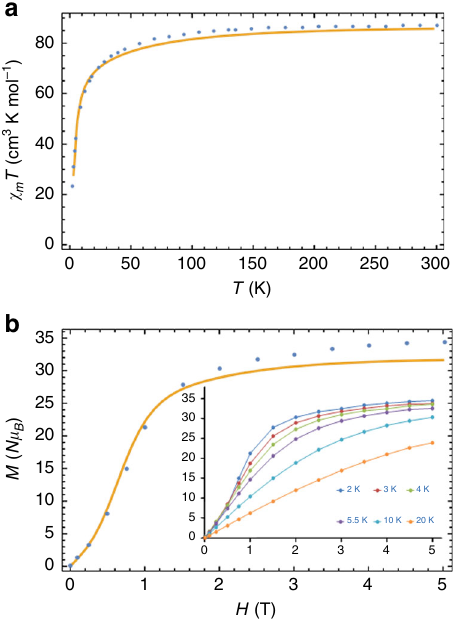
Fig. 2 Susceptibility and magnetization plots. The measured (blue circles) and simulated (via the ab initio-parameterized model, orange solid line) plot of a χ M T vs. T at 1 T and b M vs. H isotherms at 2 K for complex 1 . (inset) M vs. H isotherms for complex 1 at 2, 3, 4, 5.5, 10, and 20 K (solid lines just join the points